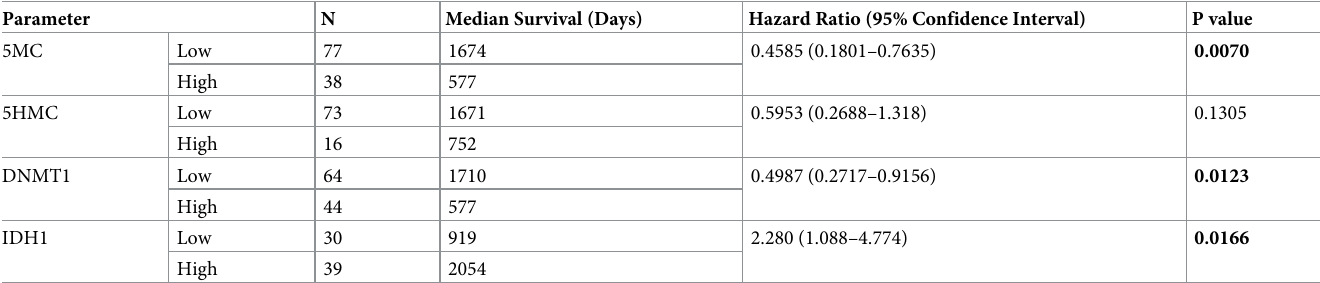
Table 2. Logrank analysis of survival time for all